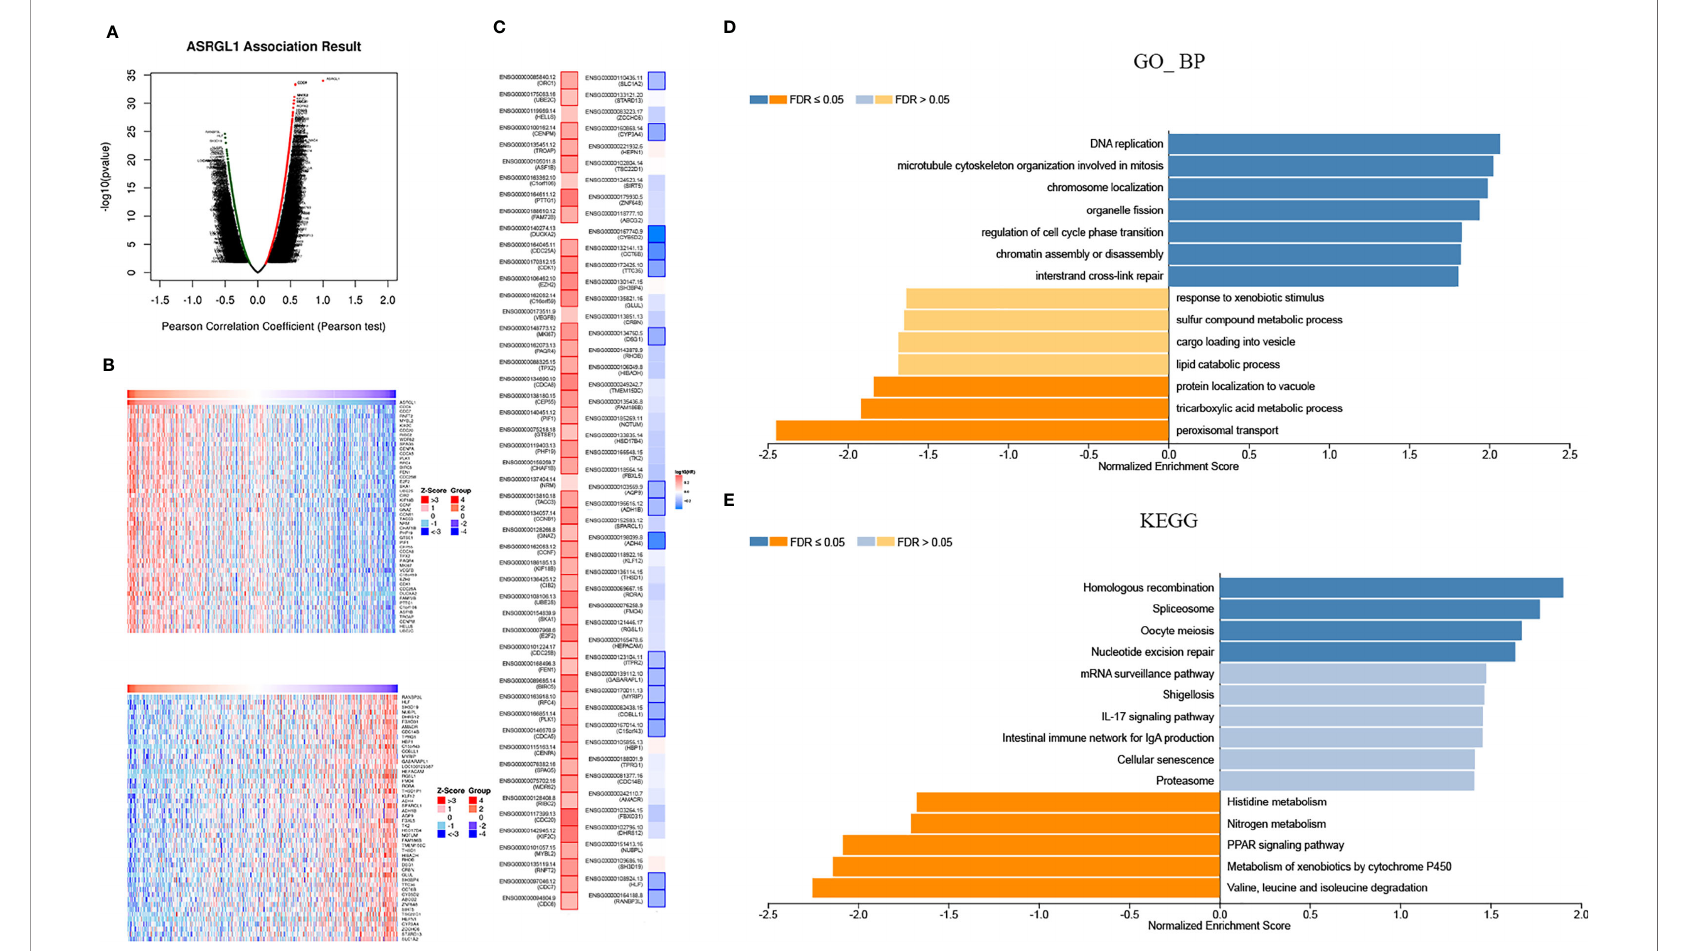
FIGURE 4 | Genes co-expressed with ASRGL1 in HCC, as determined from the LinkedOmics database. (A) Highly correlated genes identi fi ed by the Pearson test in the HCC cohort. (B) The heat maps showing top 50 genes positively and negatively correlated with ASRGL1 in HCC (red: positively correlated genes; blue: negatively correlated genes). (C) Survival maps showing the effect of the top 50 genes positively and negatively correlated with ASRGL1 in HCC. (D, E) Signi fi cantly enriched GO annotations and KEGG pathways of the genes co-expressed with ASRGL1 in HCC based on LinkedOmics